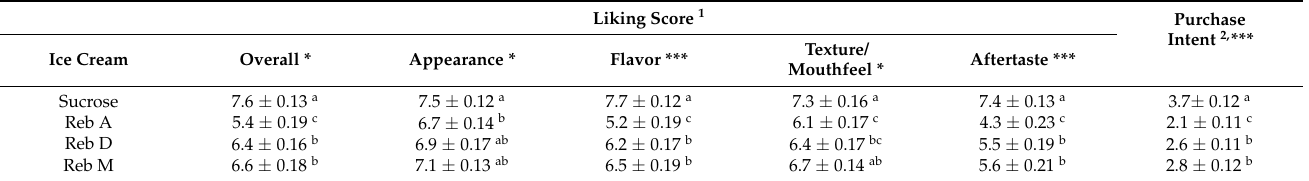
Table 6. The means ± standard error of overall liking, attribute liking, and purchase intent of sucrose, Reb A, D, and M ice cream samples ( n =